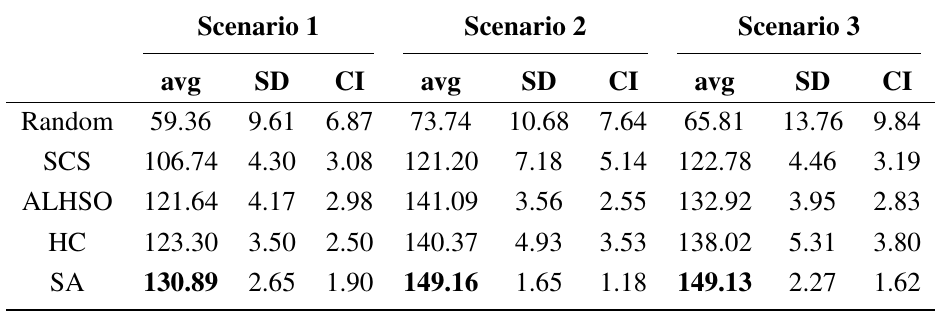
Figure 7. SA evaluation with different numbers of network providers ( p ). Table 3. Utility in scenarios with 50 APs and 350 sensors. SCS, sequential channel search; ALHSO, augmented Lagrangian harmony search optimization; HC, hill-climber.